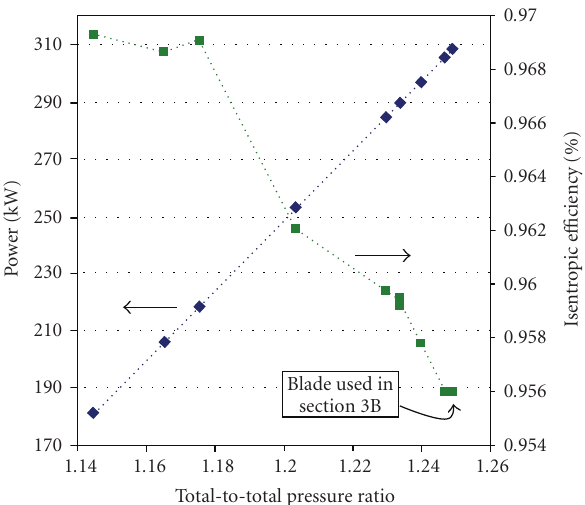
Figure 8: Pressure ratio and isentropic e ffi ciency of conventional